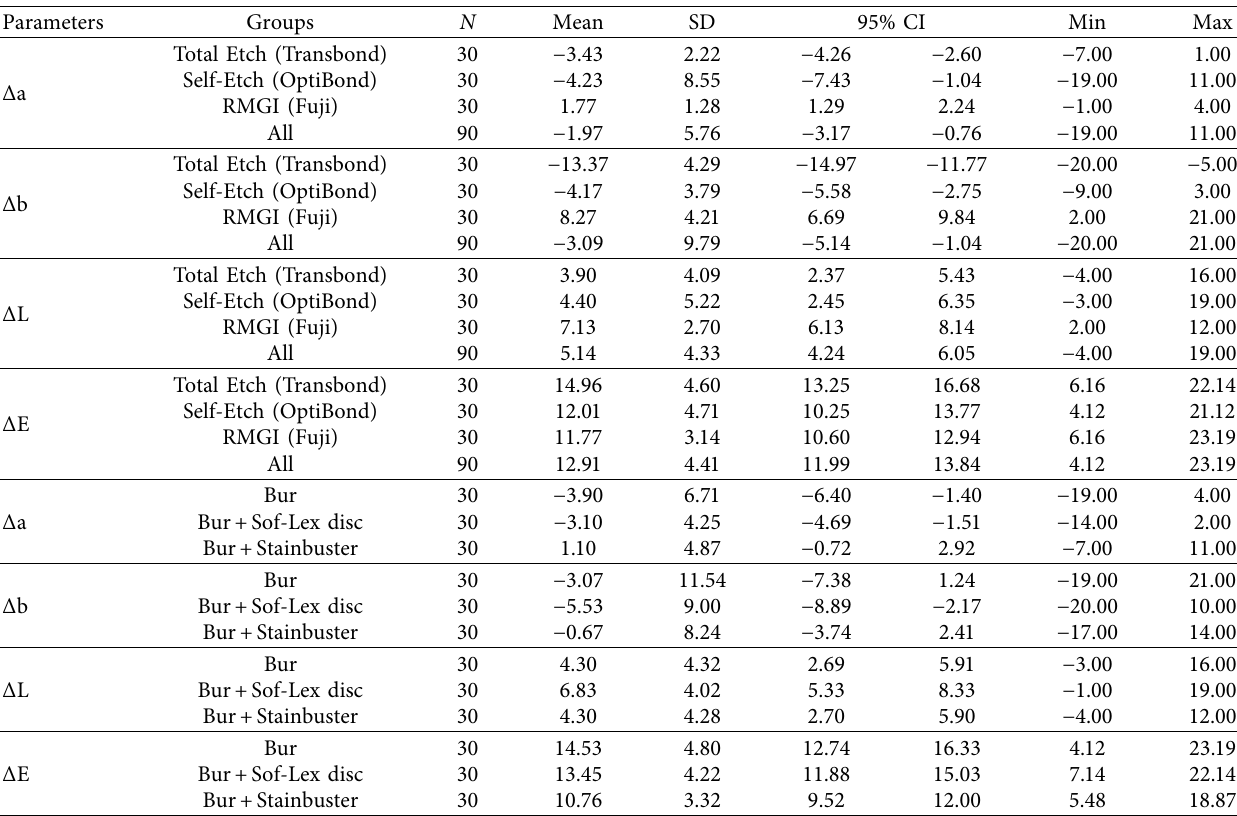
Table 2: Descriptive statistics and 95% CIs for the assessed delta parameters in each composite group ( n � 30), each resin removal group ( n � 30), and the whole sample ( n �